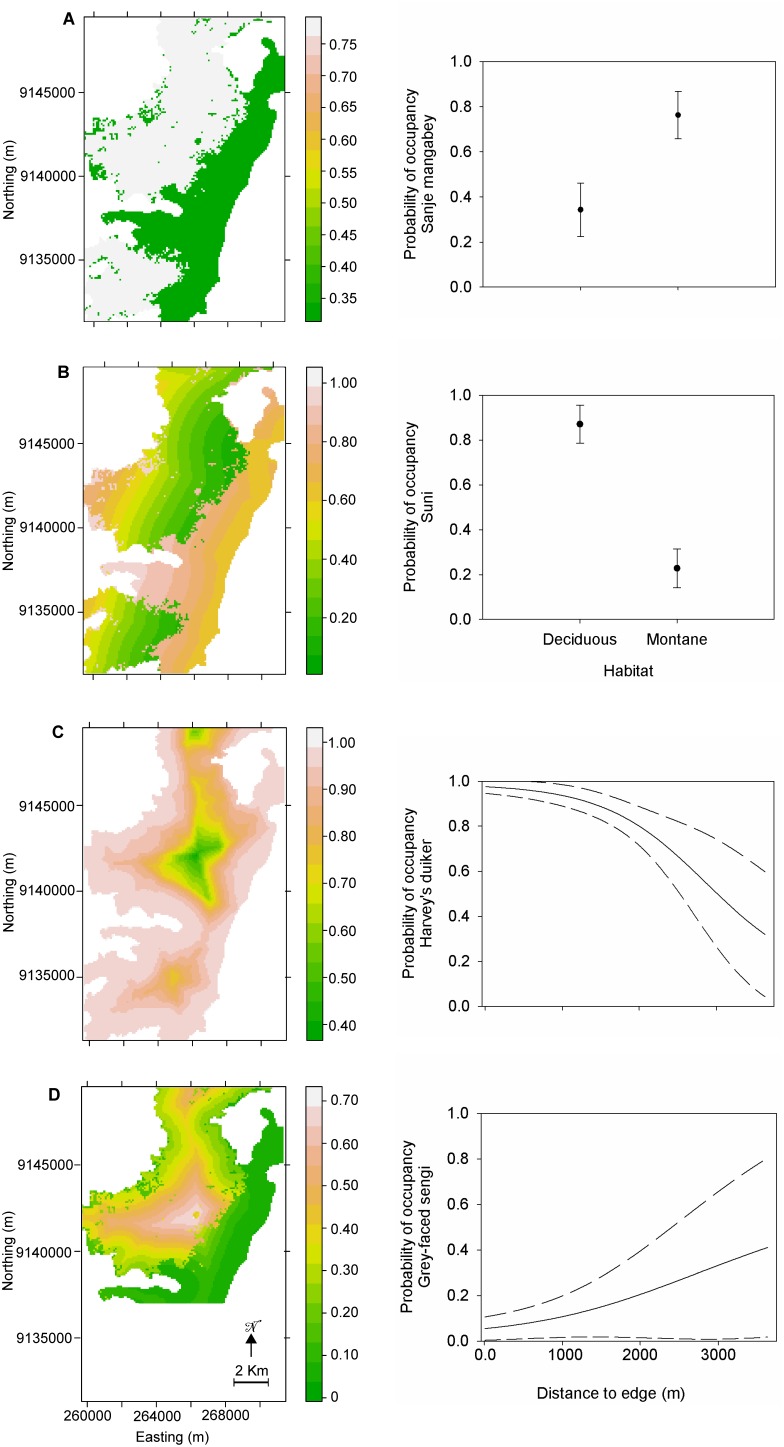
Spatially-explicit occupancy models.Maps of predicted occupancy (left) and functional relationship between the most relevant covariate and ψ (right, with confidence intervals indicated by dashed lines) for four mammals in the Udzungwa Mountains of Tanzania, representing limiting cases in occupancy pattern: (A) Sanje mangabey, a montane evergreen forest species; (B) suni, a lowland deciduous forest species; (C) Harvey’s duiker, an edge-lover and disturbance-tolerant species; (D) grey-faced sengi, an edge-avoider and disturbance-sensitive species.